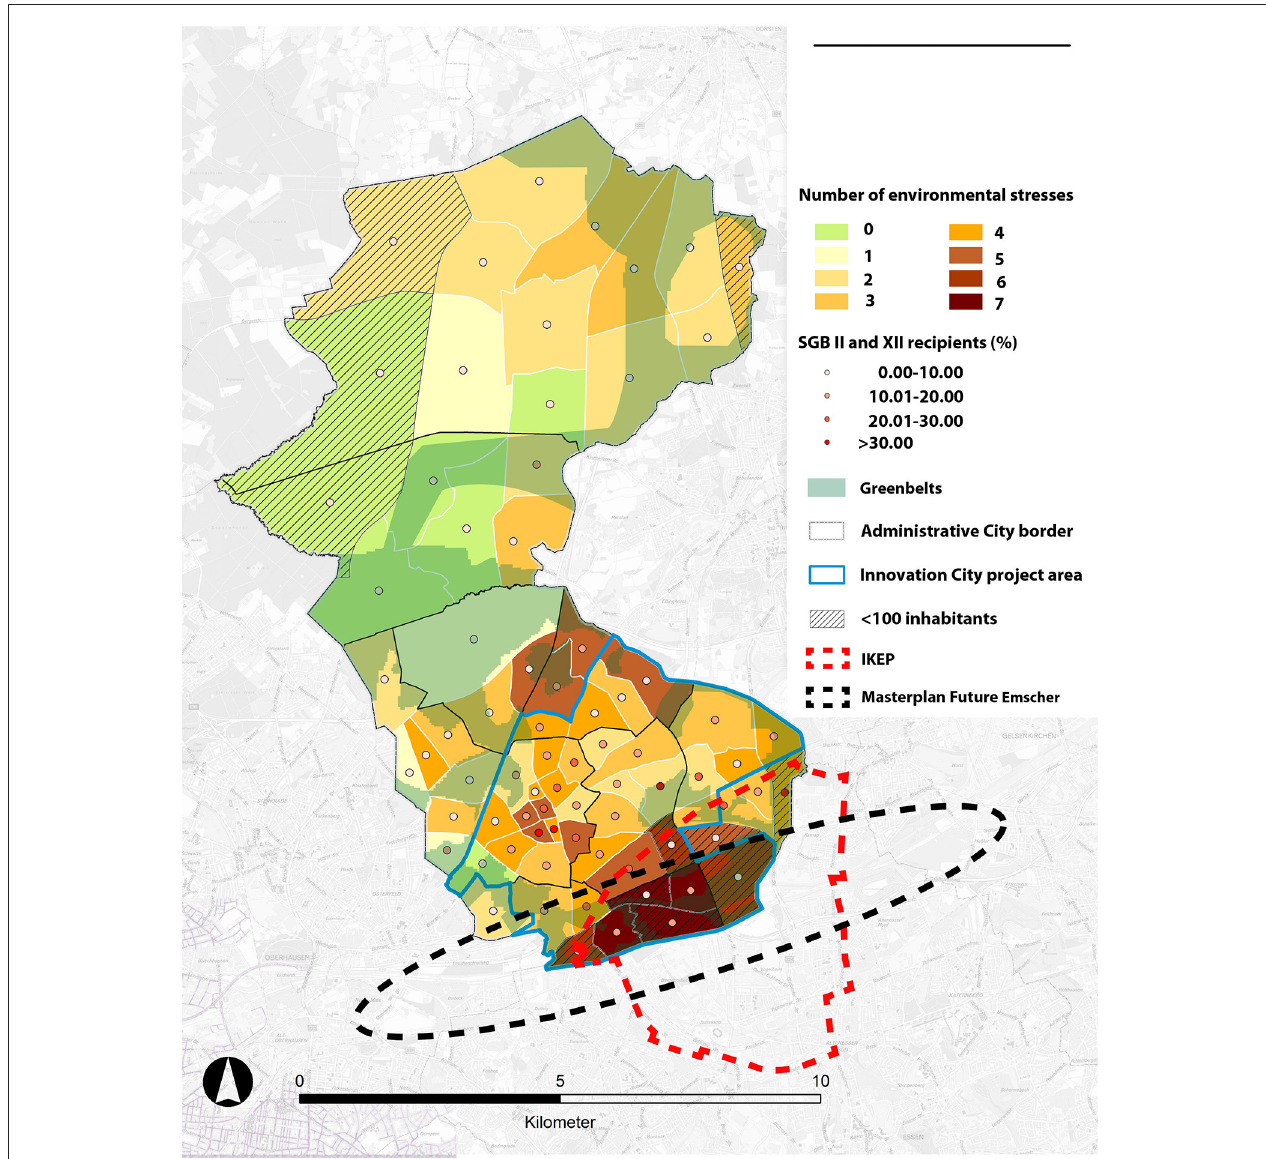
FIGURE 4 | Multiple-load map for Bottrop (modified from source: Bakunowitsch et al., 2019,